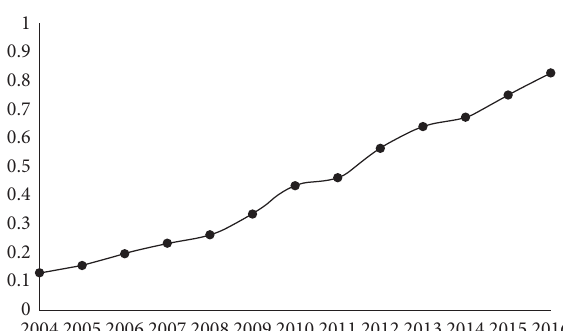
Figure 2: China’s comprehensive level of technological innovation from 2004 to